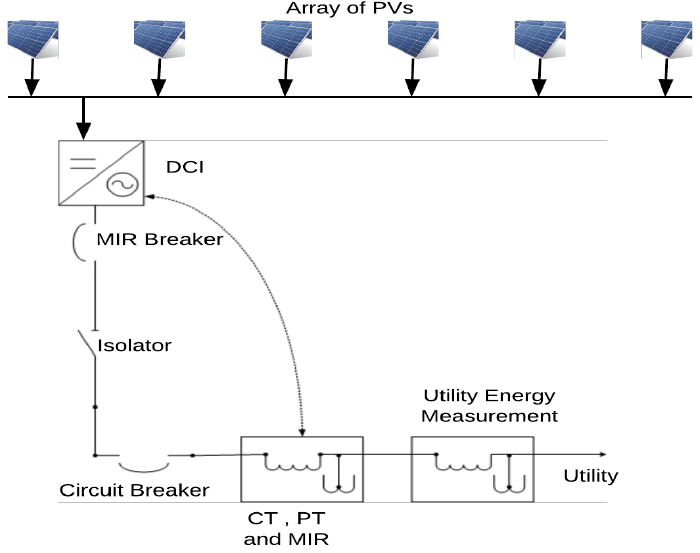
Figure 9. Integration of an MIR with a grid-connected